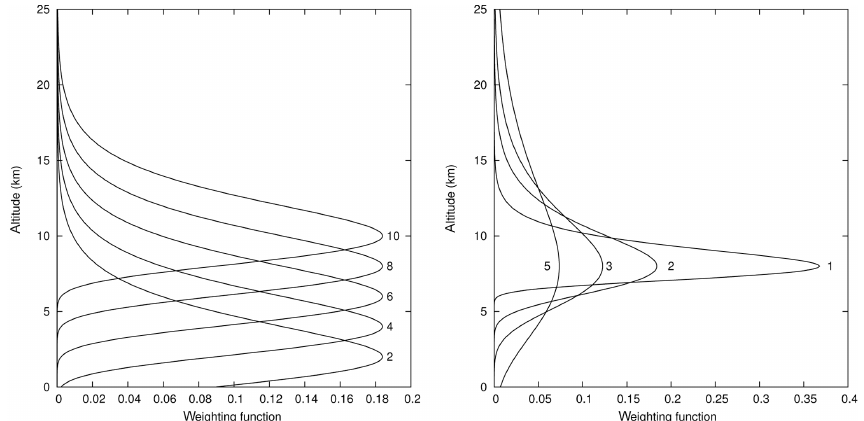
Figure 1. Generic weighting functions K(z,z,H) for water vapour spectral transitions of various line strengths (parameter z ) and for various exponential vertical profiles of water vapour concentration (scale height H ). The left panel shows the dependence of K(z) on z for a fixed scale height of 2km. The labels at the curves are the corresponding values of z in kilometres. Notice that the half widths of the weighting functions are almost independent of z . The right panel shows the dependence of K(z) on the water vapour profile, i.e. on H . The numbers at the curves indicate the chosen value of H in